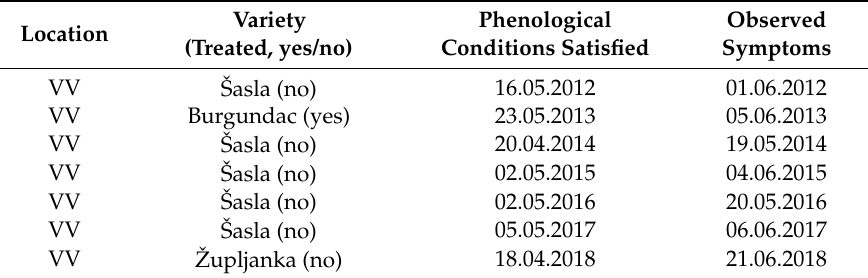
Table 2. Date when phenological conditions are satisfied (10 cm shoot length in the vineyard) and observed symptoms of downy mildew.